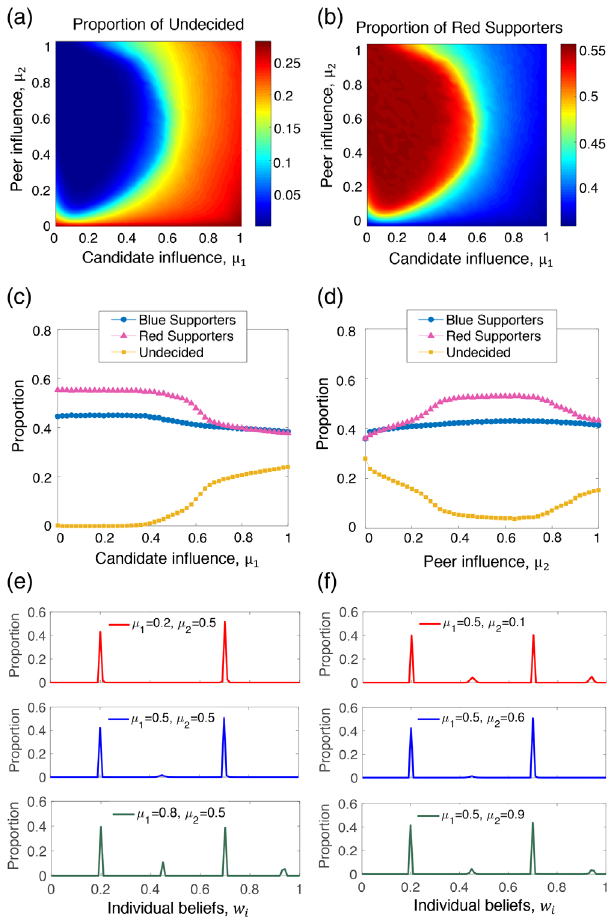
FIG. 3. Confirmation bias and attitude evolution. (a),(b) Gen- erally, moderate discussion partner influence (peer influence) and weak candidate influence lead to larger echo chambers, in this case a significantly higher proportion of red supporters and a lower proportion of undecided individuals. (c) Strong levels of candidate influence may increase the belief distance between supporters and undecided people and accelerate opinion polari- zation, which hinders sufficient social discourse and results in smaller echo chambers around candidates. (d) When candidate influence is fixed, moderate levels of discussion partner influence promote more social discourse, which reduces the size of the undecided population and effectively prevents the formation of small clusters that hold extreme opinions [also see (f)]. (e),(f) Distribution of individual beliefs in steady states, corresponding to the various situations in (c) and (d). Parameters: All simu- lations begin from an ER graph with N ¼ 10 4 , h k i ¼ 6 , Ω results are averaged over 100 independent